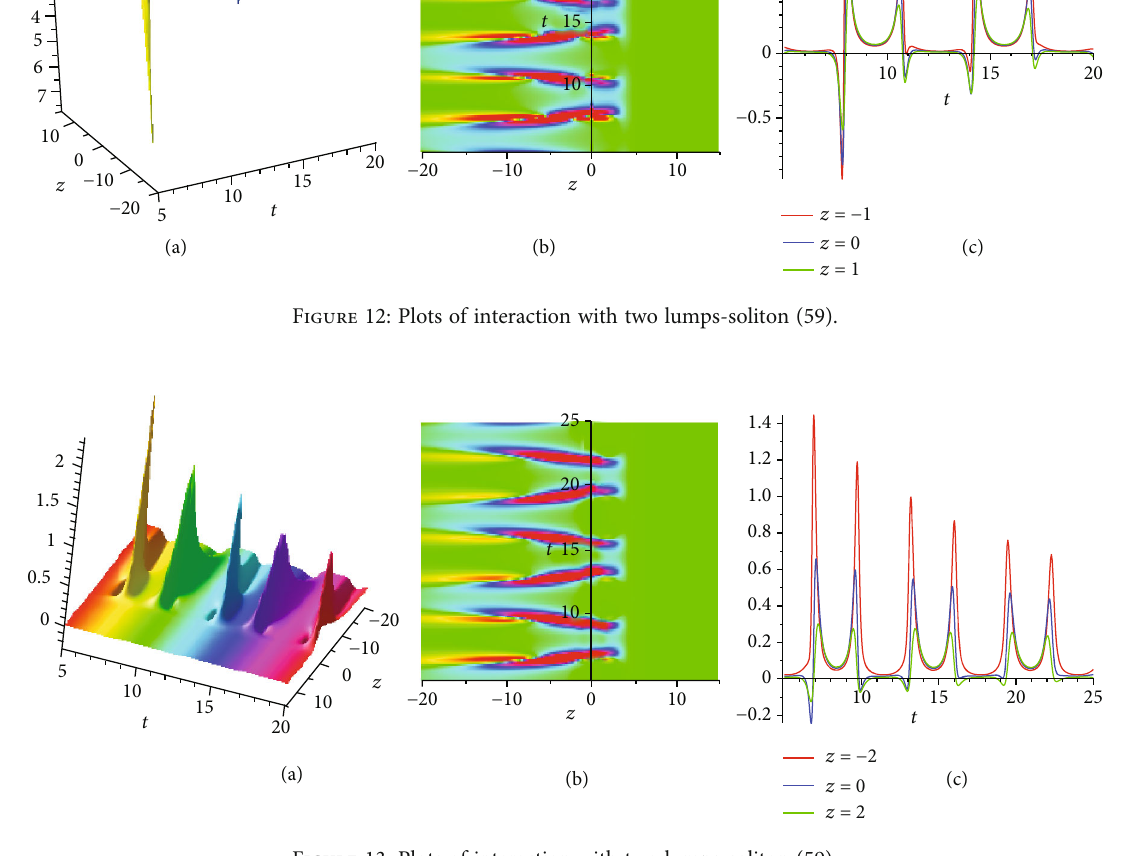
Figure 13: Plots of interaction with two lumps-soliton (59).